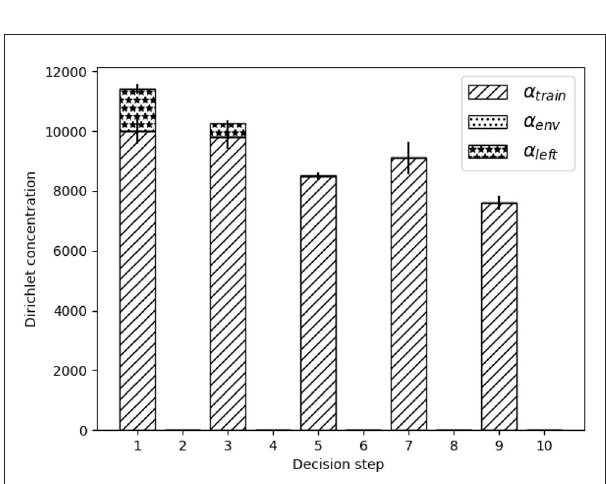
FIGURE7 Mean values of the Dirichlet concentration parameters, output of the NN to define budget distribution, per institution decision step for the training stable period. Error bars stand for standard